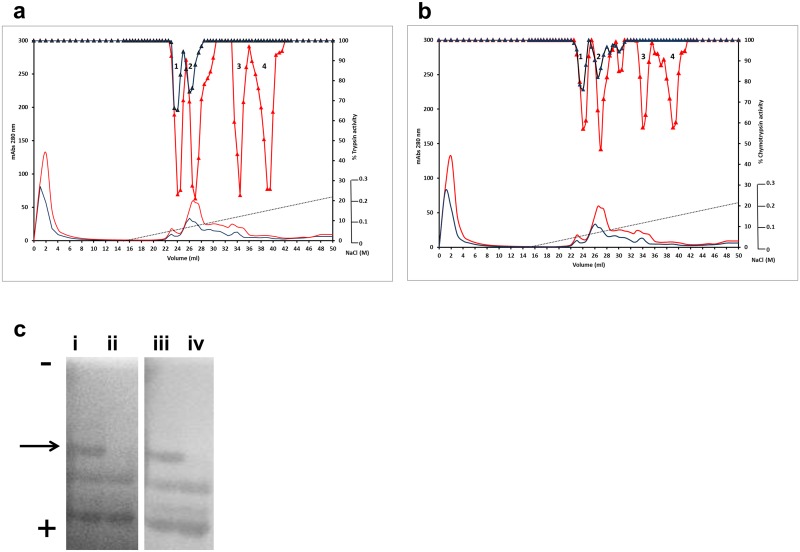
Enzyme inhibitory profile of the TI1 C77Y mutation.Seed proteins from wild-type and mutant lines from the TI1 C77Y family were separated by cation-exchange chromatography. Absorbance profiles at 280 nm are shown (a, b: red and blue lines without symbols; mAbs, left-hand scale). Using BAPNA and BTEE as specific substrates, the trypsin (a) and chymotrypsin inhibitory (b) activities of wild-type (red triangle) and mutant (blue triangl) protein fractions are shown, relative to assays where trypsin activity is 100% (control; right-hand scale). Numbers in peaks in each chromatogram correspond to the different forms of TI1 and TI2 (peak 1: TI2 processed; Peak 2: TI2 unprocessed; Peak 3: TI1 processed; Peak 4: TI1 unprocessed. (c) in-gel protease inhibitory activity of inhibitor isoforms from wild-type (i, iii) and C77Y mutant (ii, iv) lines. Zymogram blue casein gels were treated with the digestive enzymes, trypsin (i, ii) or chymotrypsin (iii, iv); dark areas indicate where the enzyme has been inhibited. The direction of electrophoresis on non-denaturing gels is indicated (-, +). The arrow indicates the position of the isoform that is missing from the mutant lines (tracks ii and iv).